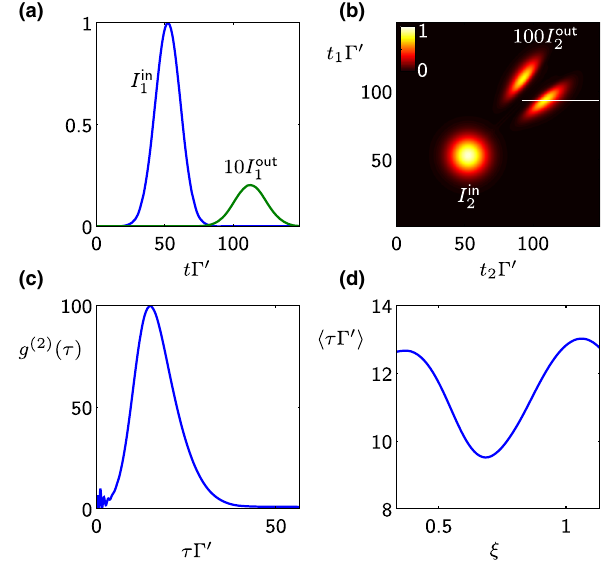
FIG. 5. Input and output of an EIT system with molecularlike interactions resulting from the potential shown in Fig. 4(a). (a) Single-photon component of input (blue line) and delayed output (green line) pulses, normalized by the peak intensity of the input pulse, where the output has been multiplied by a factor of 10 for visibility. (b) Two-photon input and output components, where the output has been scaled by a factor of 10 2 . (c) Second- order correlation function g ð 2 Þ ð τ Þ for output two-photon separa- tion time τ ¼ j t 1 − t 2 j taken along the white line shown in (b). (d) Oscillation in average two-photon separation time h τ i at output as the interaction strength and renormalized detuning are scaled to become G 0 ¼ ξ G and Δ 0 ¼ ξ Δ M . The optical depth is M 400 for plots (a) – (c) and 800 for plot (d), with G ¼ 1 . 28 Γ 0